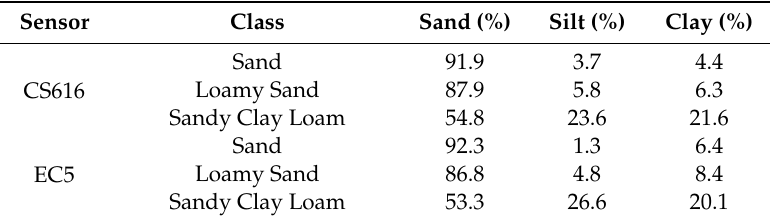
Table 2. Soil classification for field demonstration.